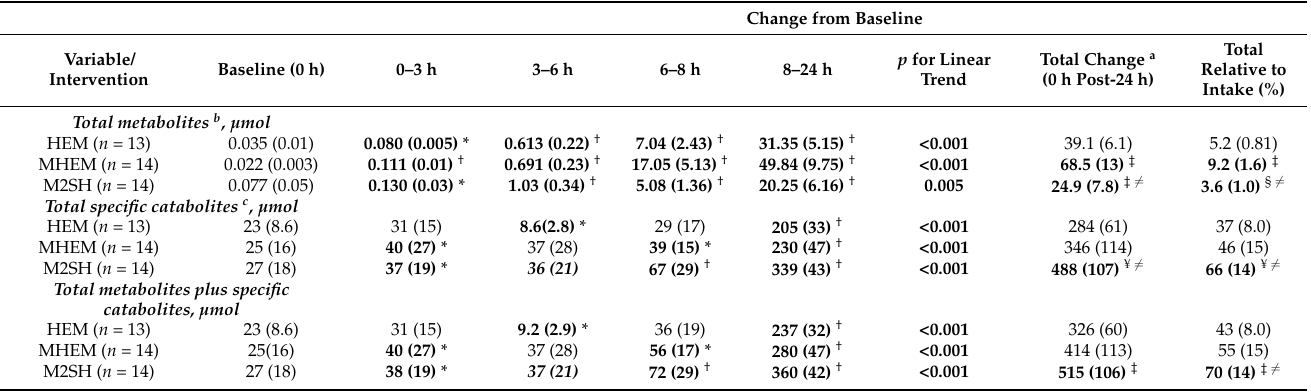
Table 2. Quantities of Hesperidin metabolites and Hesperidin catabolites in urine before and af- ter Hesperidin epimeric mixture (HEM), micronized Hesperidin epimeric mixture (MHEM) and micronized 2S-Hesperidin (M2SH)